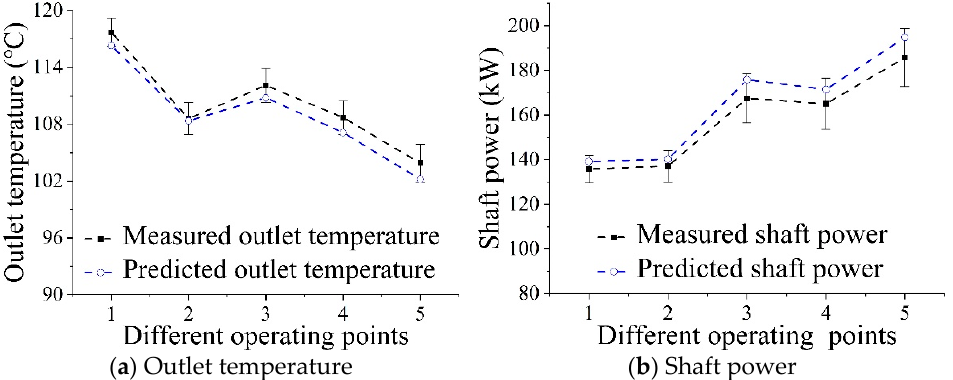
Figure 6. Comparison of the predicted value with measured ones.